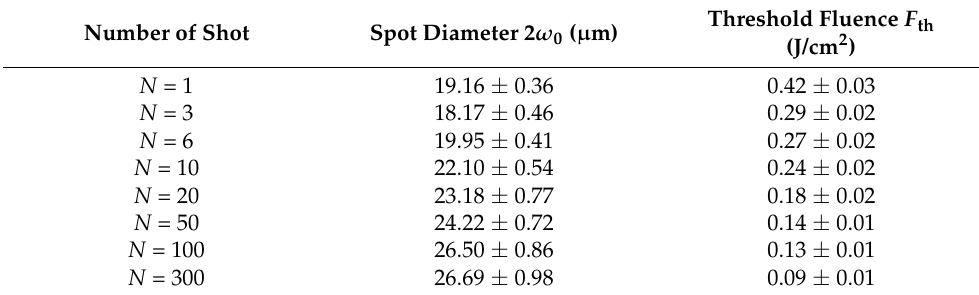
Figure 3. ( a ) Optical microscopy of ablation craters at different laser energies and pulse numbers for the 4211 resin; ( b ) statistics on the crater diameter at different pulse peak fluence for interpolating the ablation thresholds. Table 1. Laser spot diameter and diameter-regression-based ablation threshold for the epoxy resin.